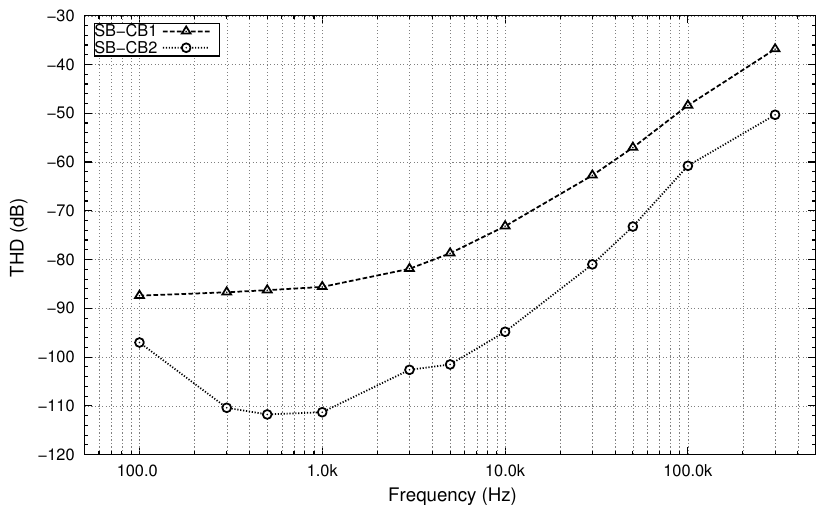
Figure 5. Output current and current transfer e r as a function of I in .